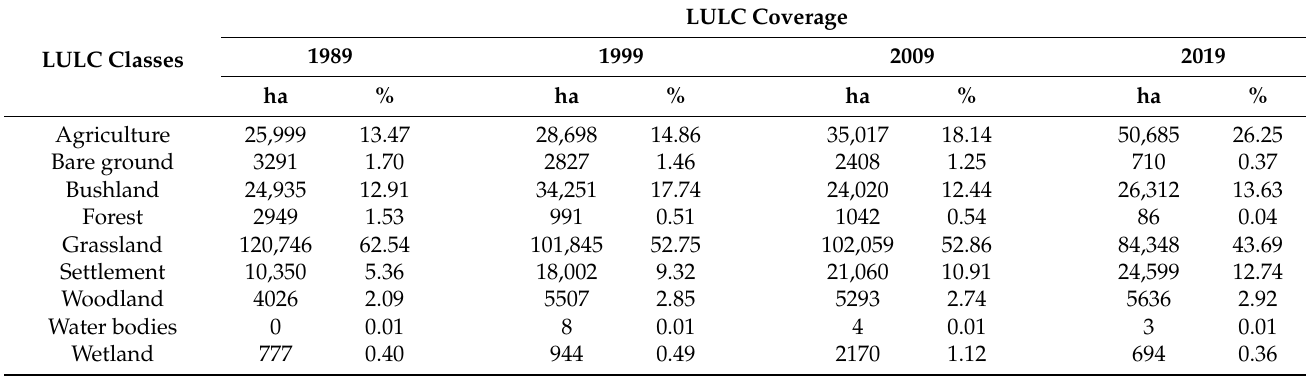
Table 2. Land Use/ Land Cover (LULC) classes (in ha and % coverage) between 1989 and 2019 in the Enduimet Wildlife Management Area, Tanzania (EWMA). Cover classes were categorized according to ([32,33]. See also Table 1.